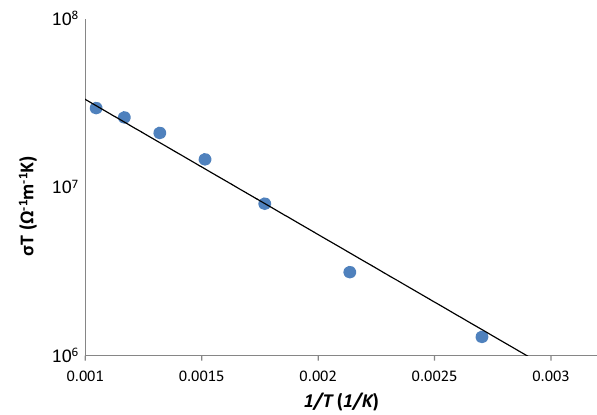
Fig. 6 Plot of ln( r T ) versus reciprocal temperature for undoped boron